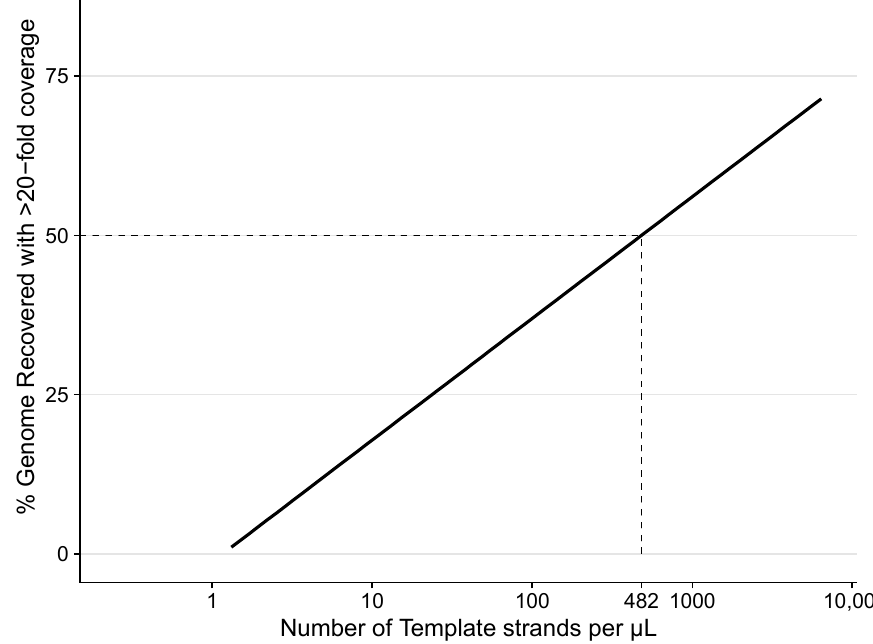
Figure 2. Successful recovery of >50% of the ISKNV genome required 482 template strands per µ L (2410 viral templates per 5 µ L sequencing reaction), with a minimum of 0.2 copies per µ L to recover >0% of the genome with at least 20-fold coverage for error correction. Number of viral templates was measured by ddPCR of a serially diluted ISKNV template, which were subsequently sequenced and processed as described in the text.